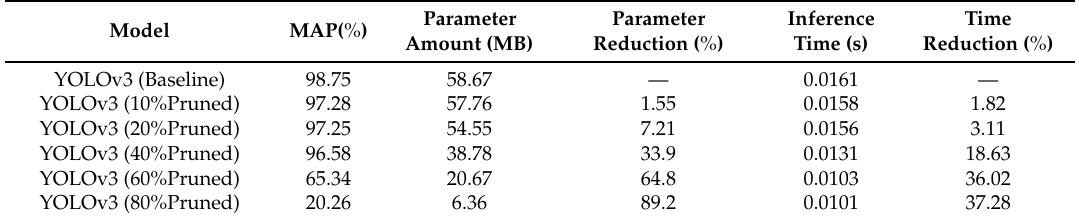
Table 3. Accuracy and speed performance under different pruning